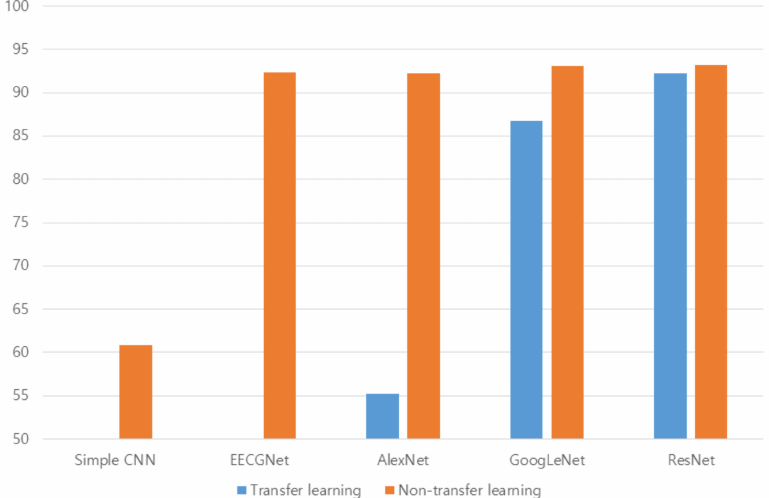
Figure 18. Comparison of the highest accuracies between transfer and nontransfer learning on